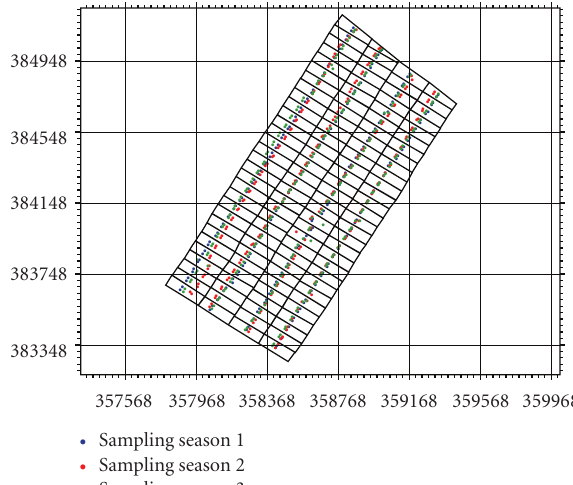
Figure 1: Map of the soil chemical and physical sampling points in block